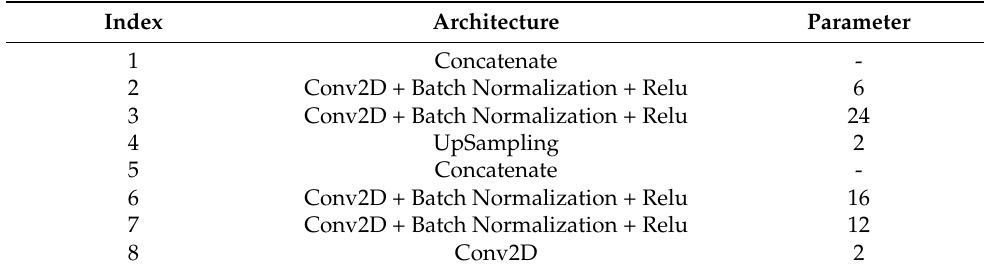
Table 2. Refiner model of the DeepLabV3-Refiner